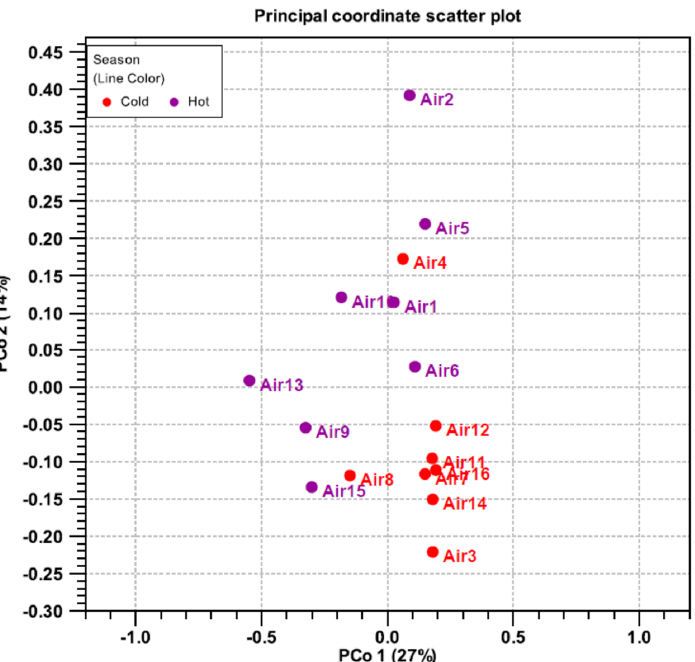
Figure 9. Diversity principal coordinate analysis of cultivable airborne bacteria collected from four PHCCs and analyzed based on 16SrRNAA sequencing during the hot and cold seasons.